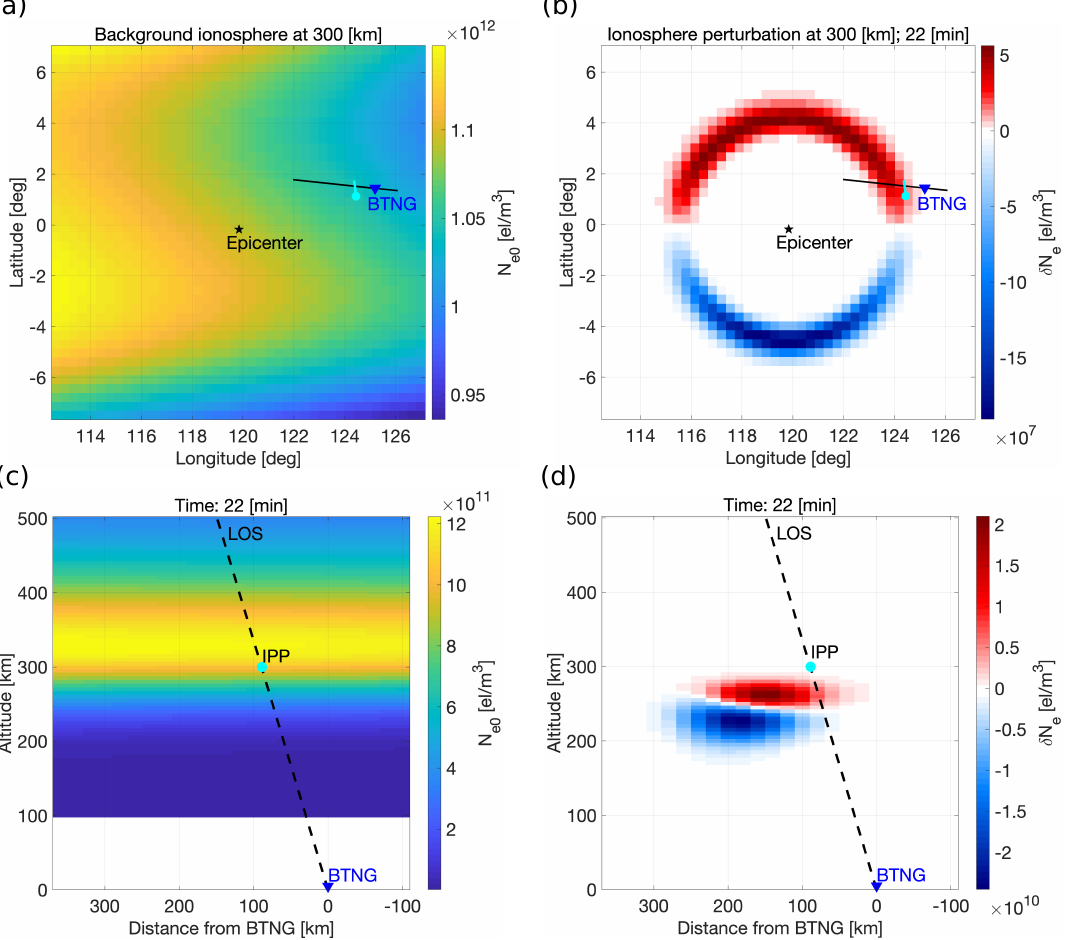
Figure 5. Background electron density ( a ); and electron density perturbation 22 min after rupture ( b ) at an altitude of 300 km. The cyan line shows the track of the IPP at 300 km, with the circle indicating the end of the track 3500 s after the rupture. Blue triangle is the GNSS station BNTG at the ground surface. The solid black line indicates the vertical plane shown in ( c , d ). Background electron density ( c ); and electron density perturbation ( d ) in a vertical plane along the satellite-receiver LOS at 22 min (GPS satellite